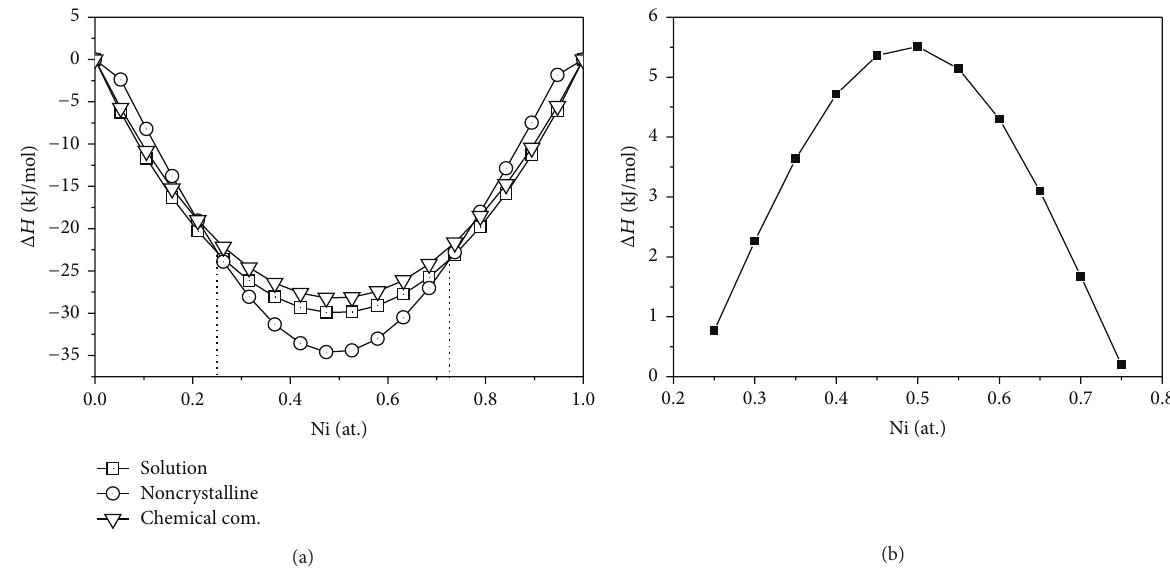
Figure 4: The formation enthalpies as function of the composition of Ni.